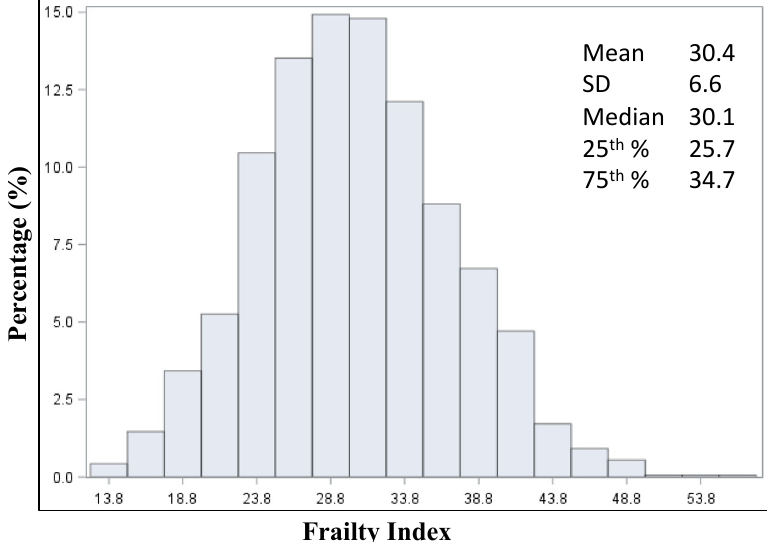
Figure 1. Distribution and summary statistics of the frailty index.